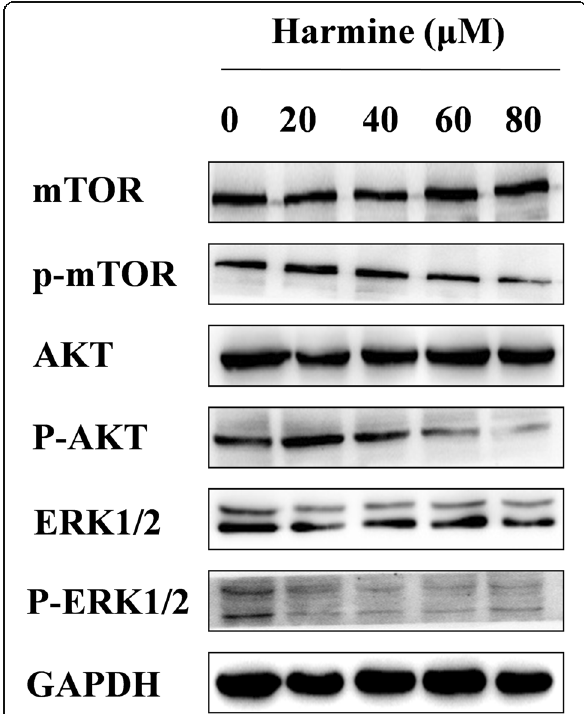
Fig. 6 The western blot analysis for mTOR, p-mTOR, Akt, p-Akt, ERK1/2 and p-ERK1/2 signaling pathway of B16 cells induced by har- mine treated with 20, 40, 60, 80 μ M for 1